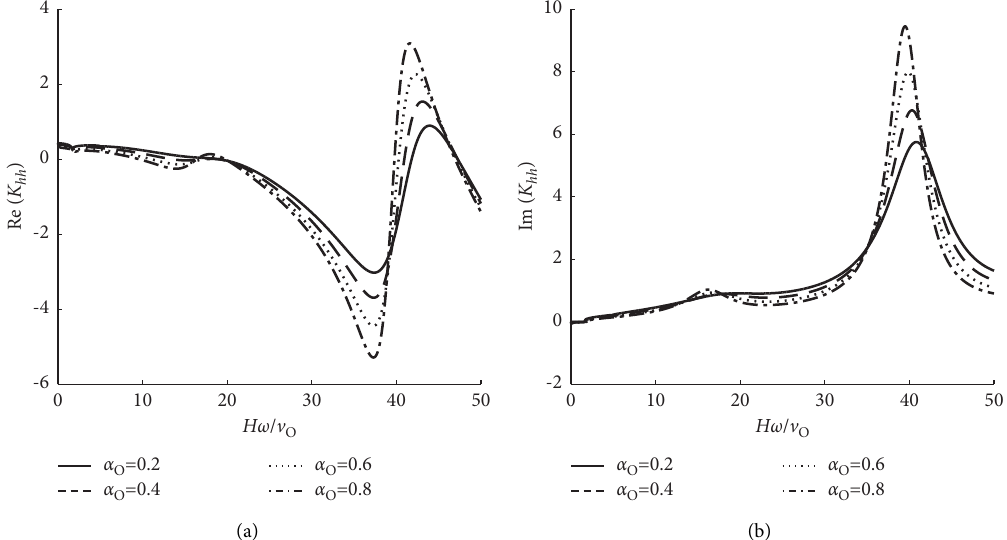
Figure 12: The horizontal dynamic impedance curves of pipe pile under different orders of fractional derivative viscoelastic model of the soil around pile. (a) Real part of horizontal dynamic impedance. (b) Imaginary part of horizontal dynamic